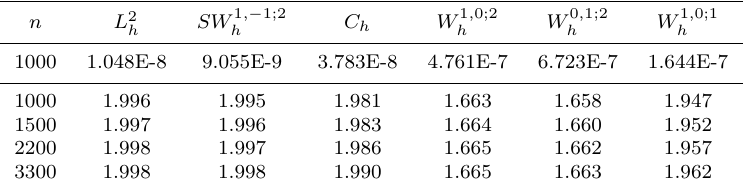
Table 21. Practical errors and error orders in Example C 1 / 2 ,